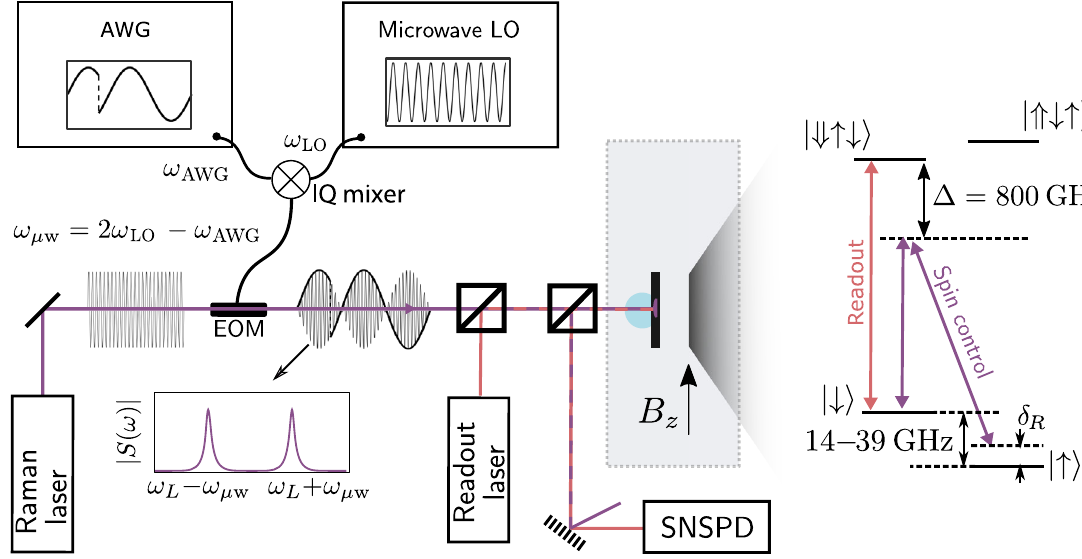
FIG. 7. Optical and microwave setup. Adapted from Ref. [48]. From left to right we have a Raman laser 800 GHz detuned from the trion manifold that is fed through an electro-optic modulator (EOM). The EOM is driven by a microwave signal derived from the IQ mixing of an arbitrary waveform generator (AWG) with a local oscillator (LO). The EOM output is then 2 coherent laser fields. A beam splitter combines the Raman laser with a resonant laser for readout, which is sent to the sample. The sample sits in a bath cryostat at 4 K, with a 3.5 T magnetic field applied in Voigt geometry. The QD emission is collected and excitation light is filtered by polarization and color before being counted on a superconducting-nanowire single-photon detector (SNSPD). The rightmost section depicts the QD energy level diagram and excitation laser